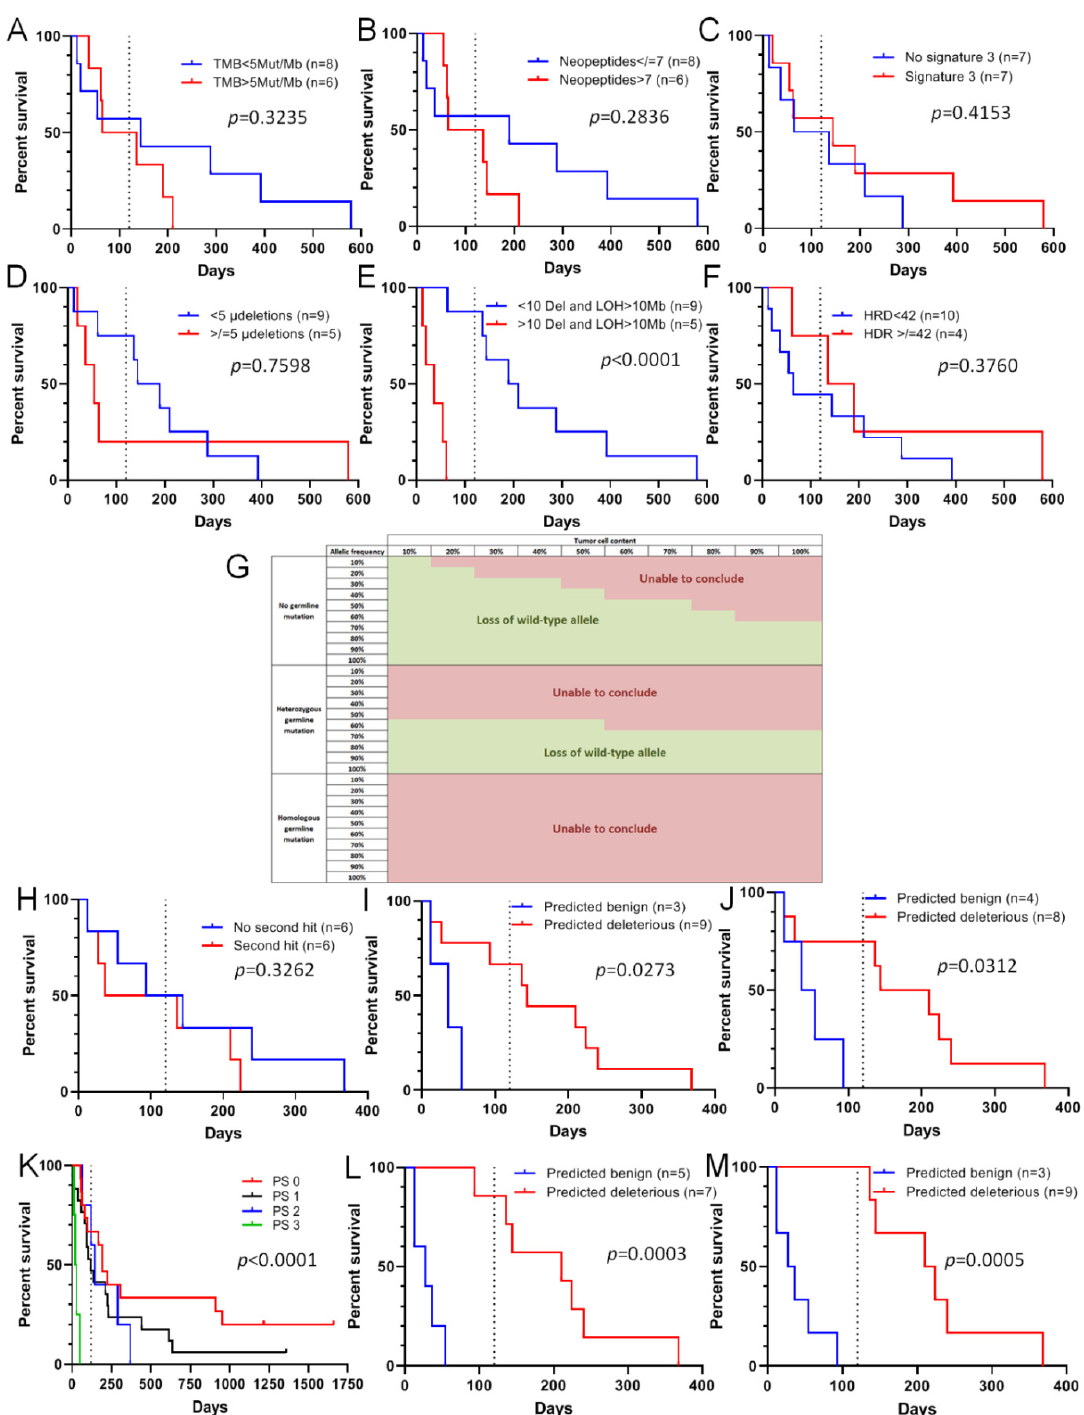
Figure 3. Sensitivity of VUS-containing tumors to olaparib can be assessed in silico . ( A – F ): Progression-free survival (PFS) for patients receiving olaparib treatment according to tumor mutational burden (TMB) ( A ), the number of neopeptides ( B ), the presence of Alexandrov’s signature 3 ( C ), the number of microdeletions ( D ), homologous recombination deficiency (HRD) score ( E ), and the number of large deletions and loss of heterozygosity (LOH) > 10 Mb ( F , G ): A table enabling the determination of possible LOH depending on the tumor cell content and the allele frequency of alternative variants. Green zones correspond to putative loss of the wild-type allele. ( H – M ). PFS under olaparib treatment according to the presence of the second hit ( H ), variant pathogenicity predicted by PROVEAN ( I ) or Dann ( J ), patient Performance Status ( K ), variant pathogenicity predicted by combination of loss of wild-type allele, Performance status and PROVEAN ( L ) or Dann ( M ) predictions. For all panels: the dashed line corresponds to 120